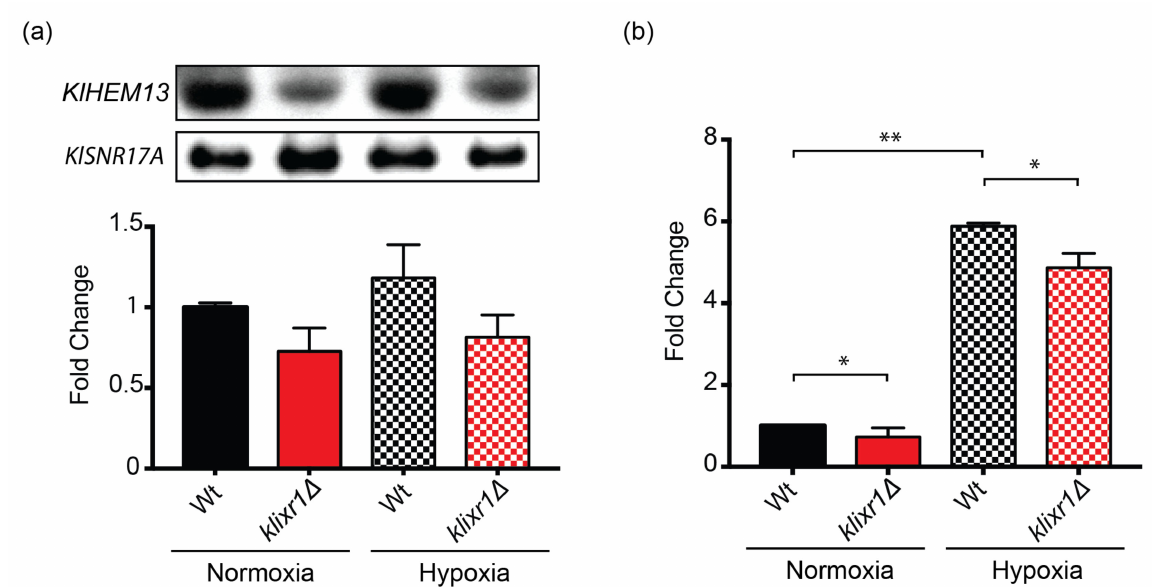
Figure 4. Effect of KlIXR1 disruption on KlHEM13 expression under aerobic (solid) or hypoxic conditions (grid) in the MW190-9b strain from K. lactis were analyzed by ( a ) Northern blot and ( b ) RT-qPCR experiments. Blots for ( a ) were obtained in triplicate experiments and a representative picture is shown in upper left panel. KlSNR17A and KlTAF10 signal levels were used as references for normalization in ( a , b ), respectively. * p < 0.05; ** p <